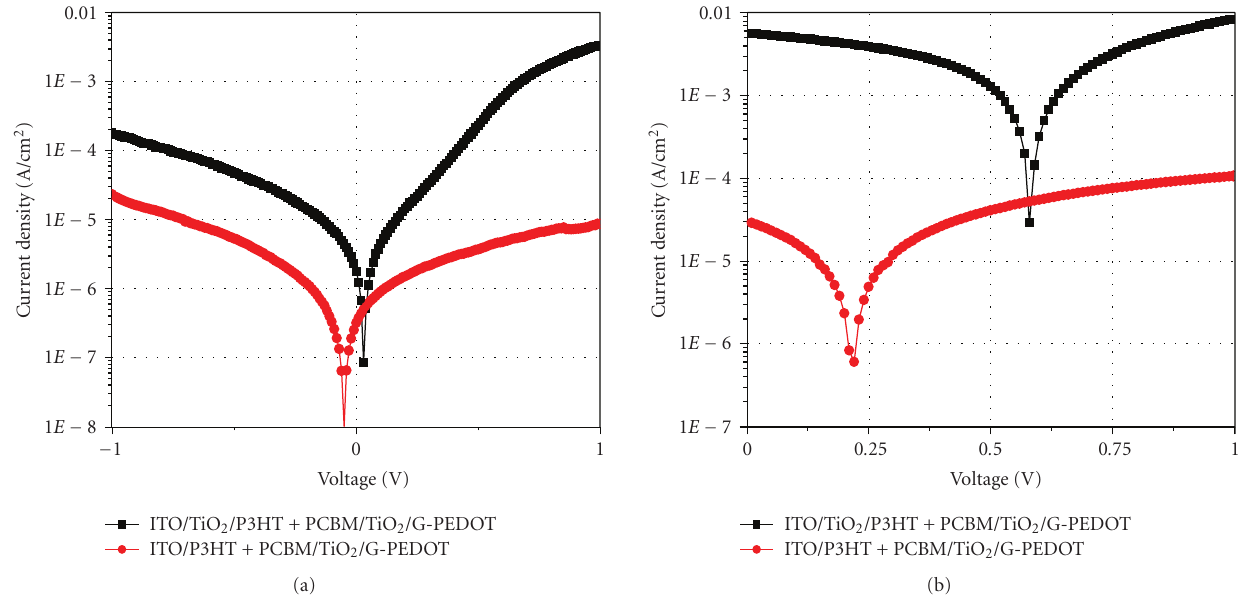
Figure 5: I–V characteristics of ITO/TiO 2 /P3HT+PCBM/TiO 2 /G-PEDOT (square) and ITO/P3HT+PCBM/TiO 2 /G-PEDOT (circles). (a) I–V characteristics of device in dark condition. (b) I–V characteristics measured under white illumination (Xe lamp, 80mW/cm 2 ). Devices’ performance: (square) Jsc = 5.7 mA/cm 2 Voc = 0.59 V FF = 0.33 η = 1.38%, (circles) Jsc = 0.03 mA/cm 2 Voc = 0.22 V FF = 0.25 η =